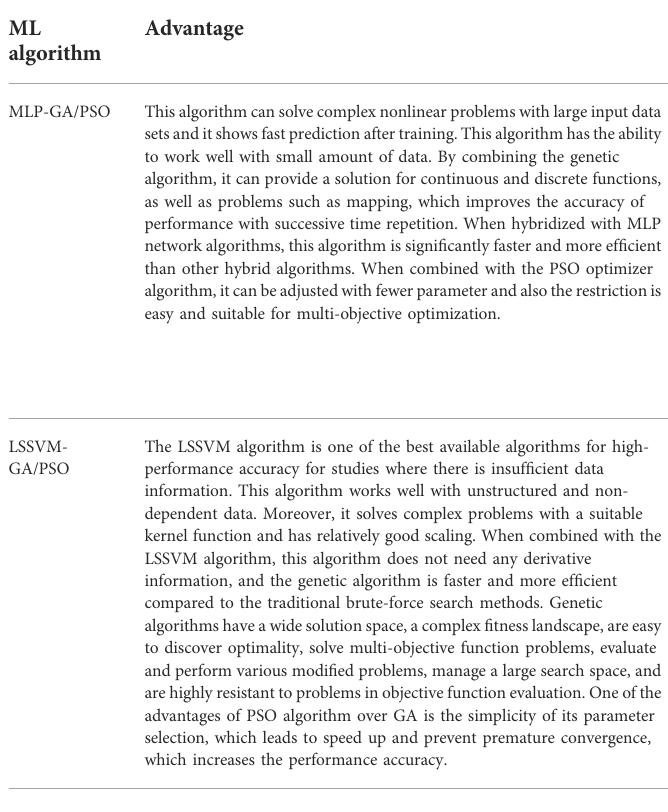
TABLE 1 Compare the advantage and disadvantages of hybrid machine learning algorithms used for FVDC